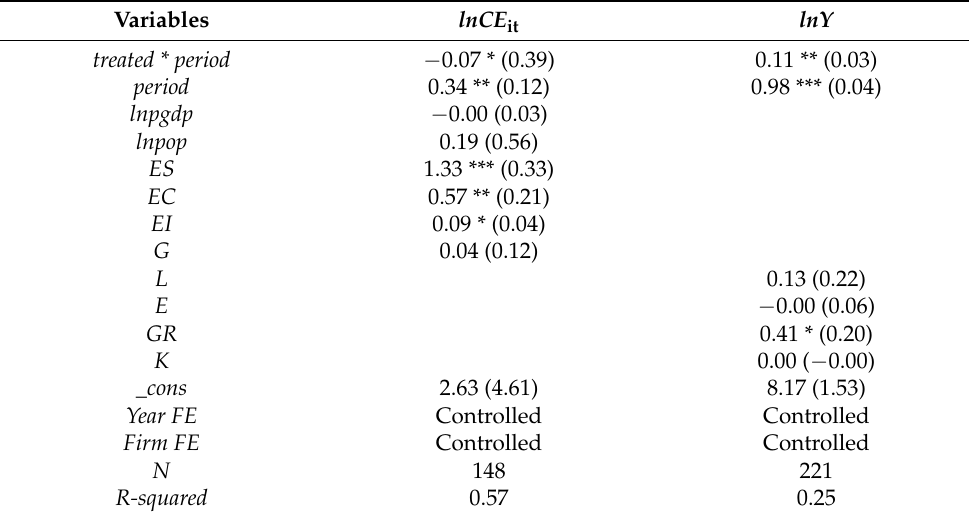
Table 3. PSM-DID regression